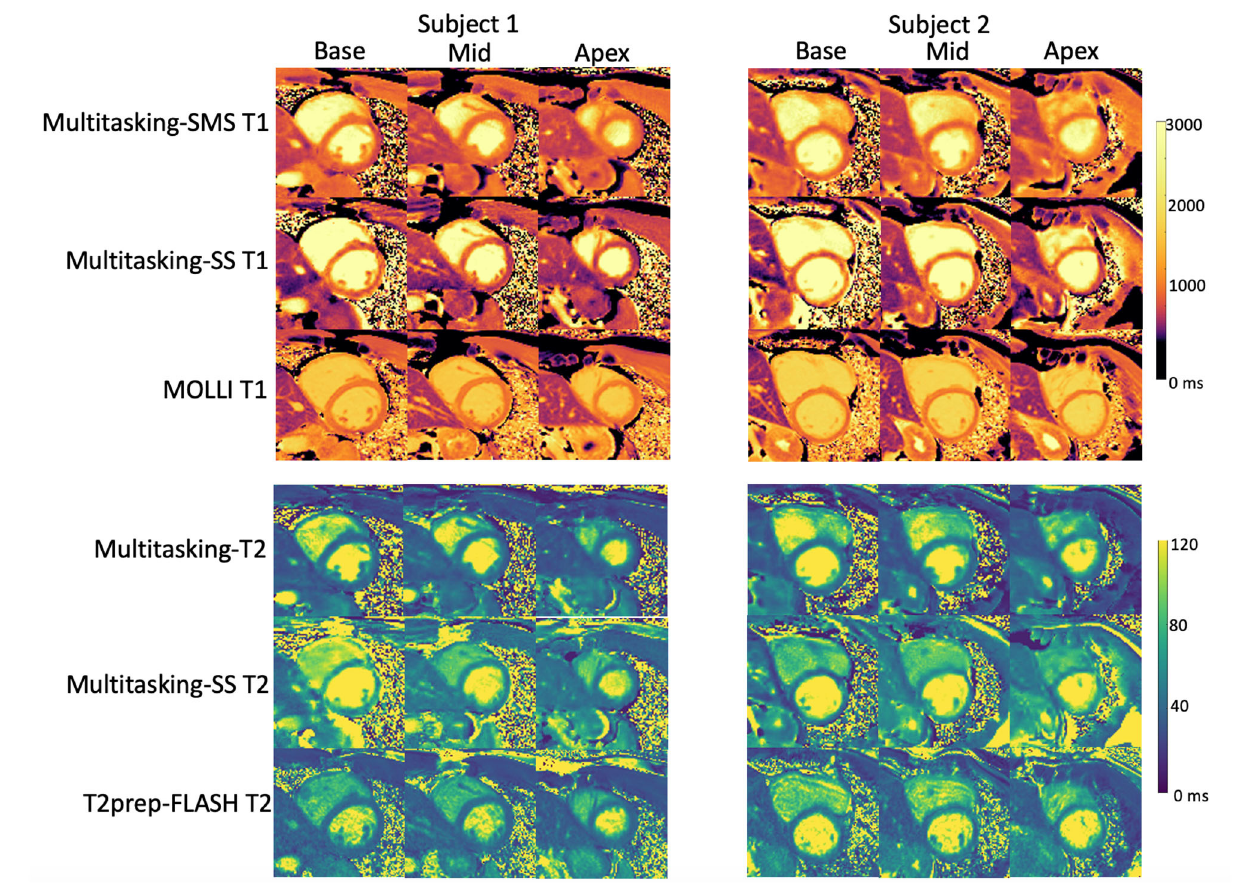
FIGURE 6 | Comparison between T1/T2 maps obtained with the proposed 2D Multitasking-SMS, the original Multitasking-SS, and the standard MOLLI/T2-prep FLASH approaches in two healthy subjects. The acquired Multitasking T1/T2 maps were the same slice position as the reference maps acquired in the short axis.